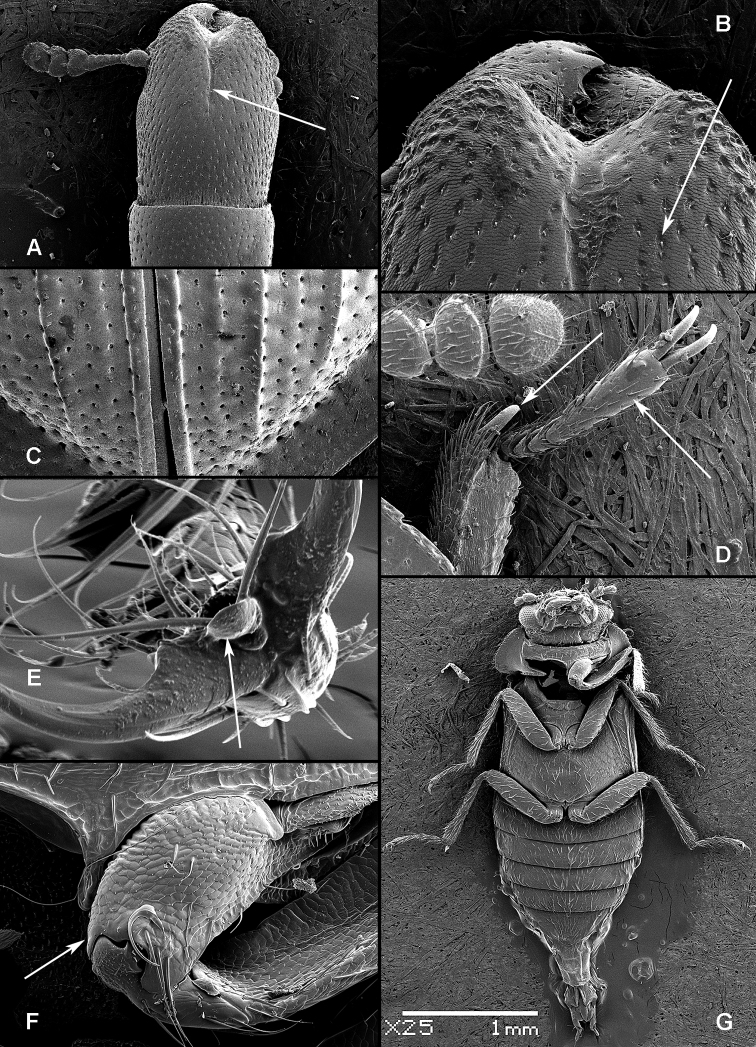
A–B
Nemozoma elongatum (A cranium with longidutinal groove B detail of elongate punctures) C–D
Peltis ferruginea (C elytral apex D antennal club, hooked spur and protarsus with large 5th tarsomere) E–G
Phloiophilus edwardsi (E metatarsal claws and empodium F projecting procoxae G ventral surface).